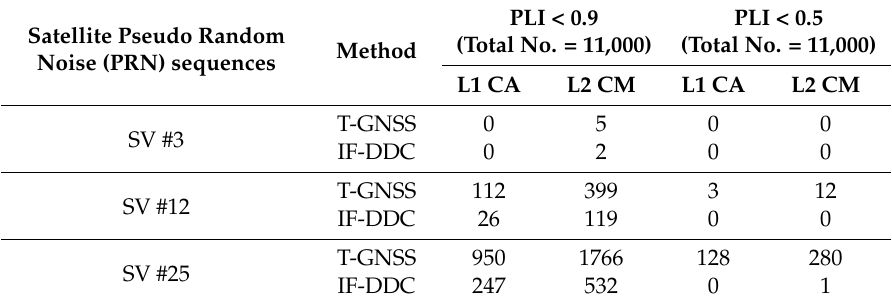
Table 5. Summary of tracking performance under scintillation.